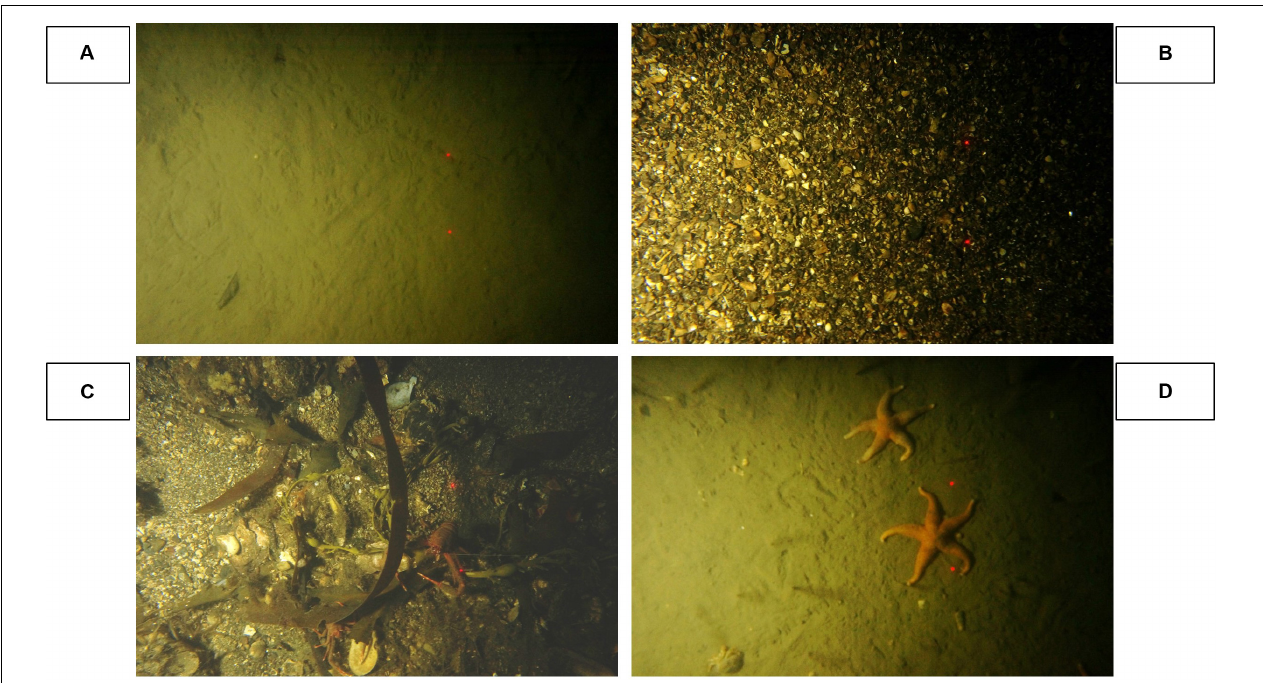
FIGURE 5 | (A–D) Example Loch Creran seabed images collected by the BGS benthic tow fish. Sediment types were classified using a simplified Folk Scheme, thus: (A) T4 – Mud (M); (B) T6 – Gravel (G); (C) T1 – gravelly Sand (gS); (D) T3 – sandy Mud (sM). Spatial locations of the benthic tow transects (T1–T9) are shown in Figure 3B . Red dots represent 10 cm laser spot separation for